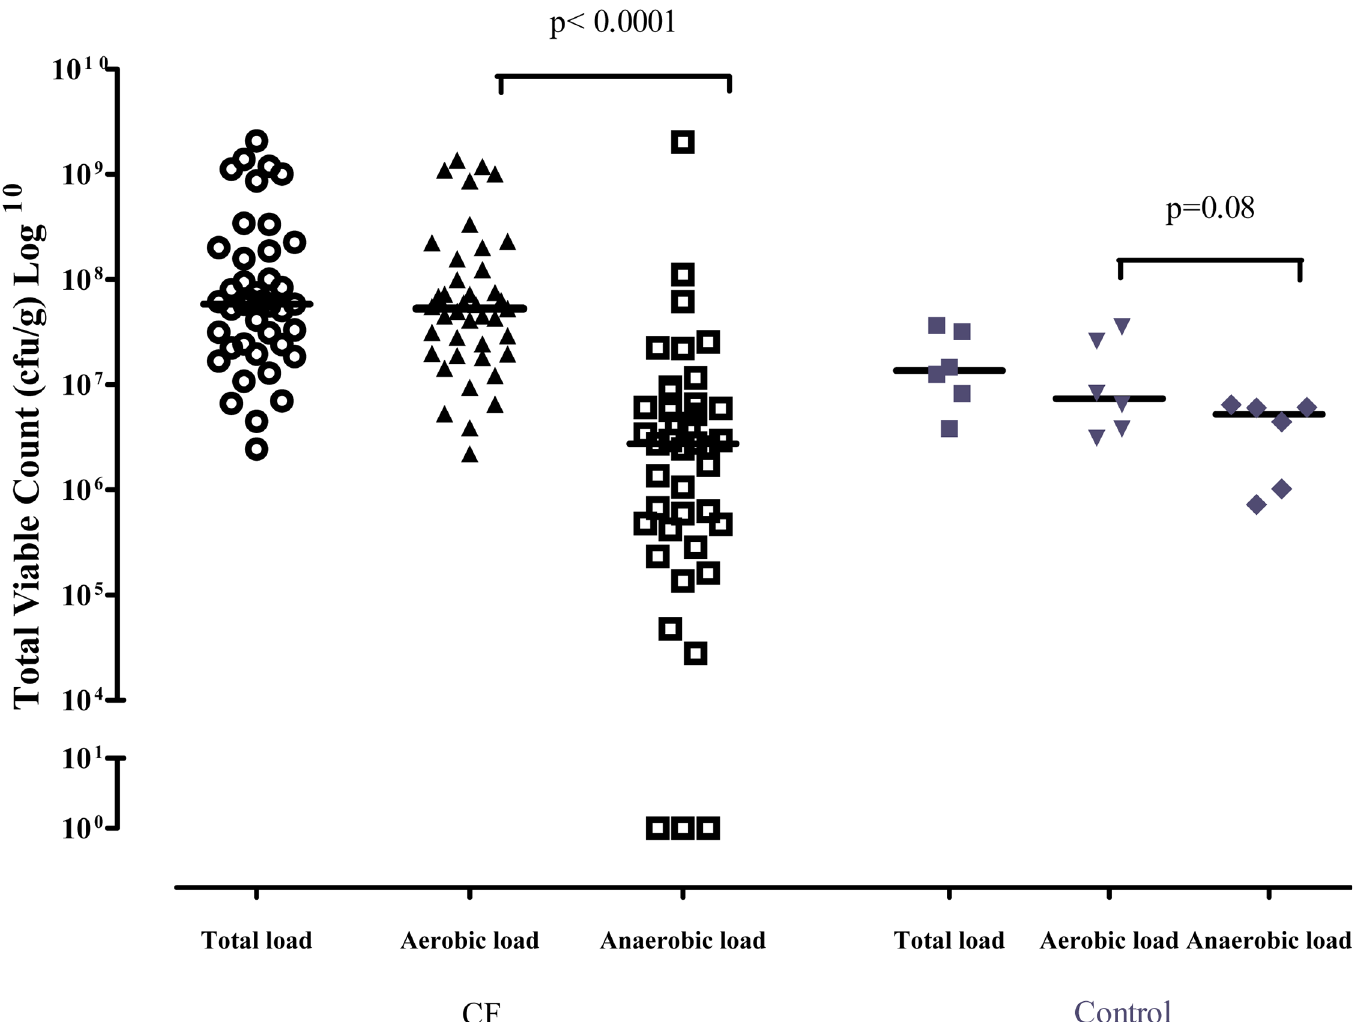
Fig 1. Total colony count, aerobic colony count and anaerobic colony count of bacteria in sputum from CF patients and control subjects.